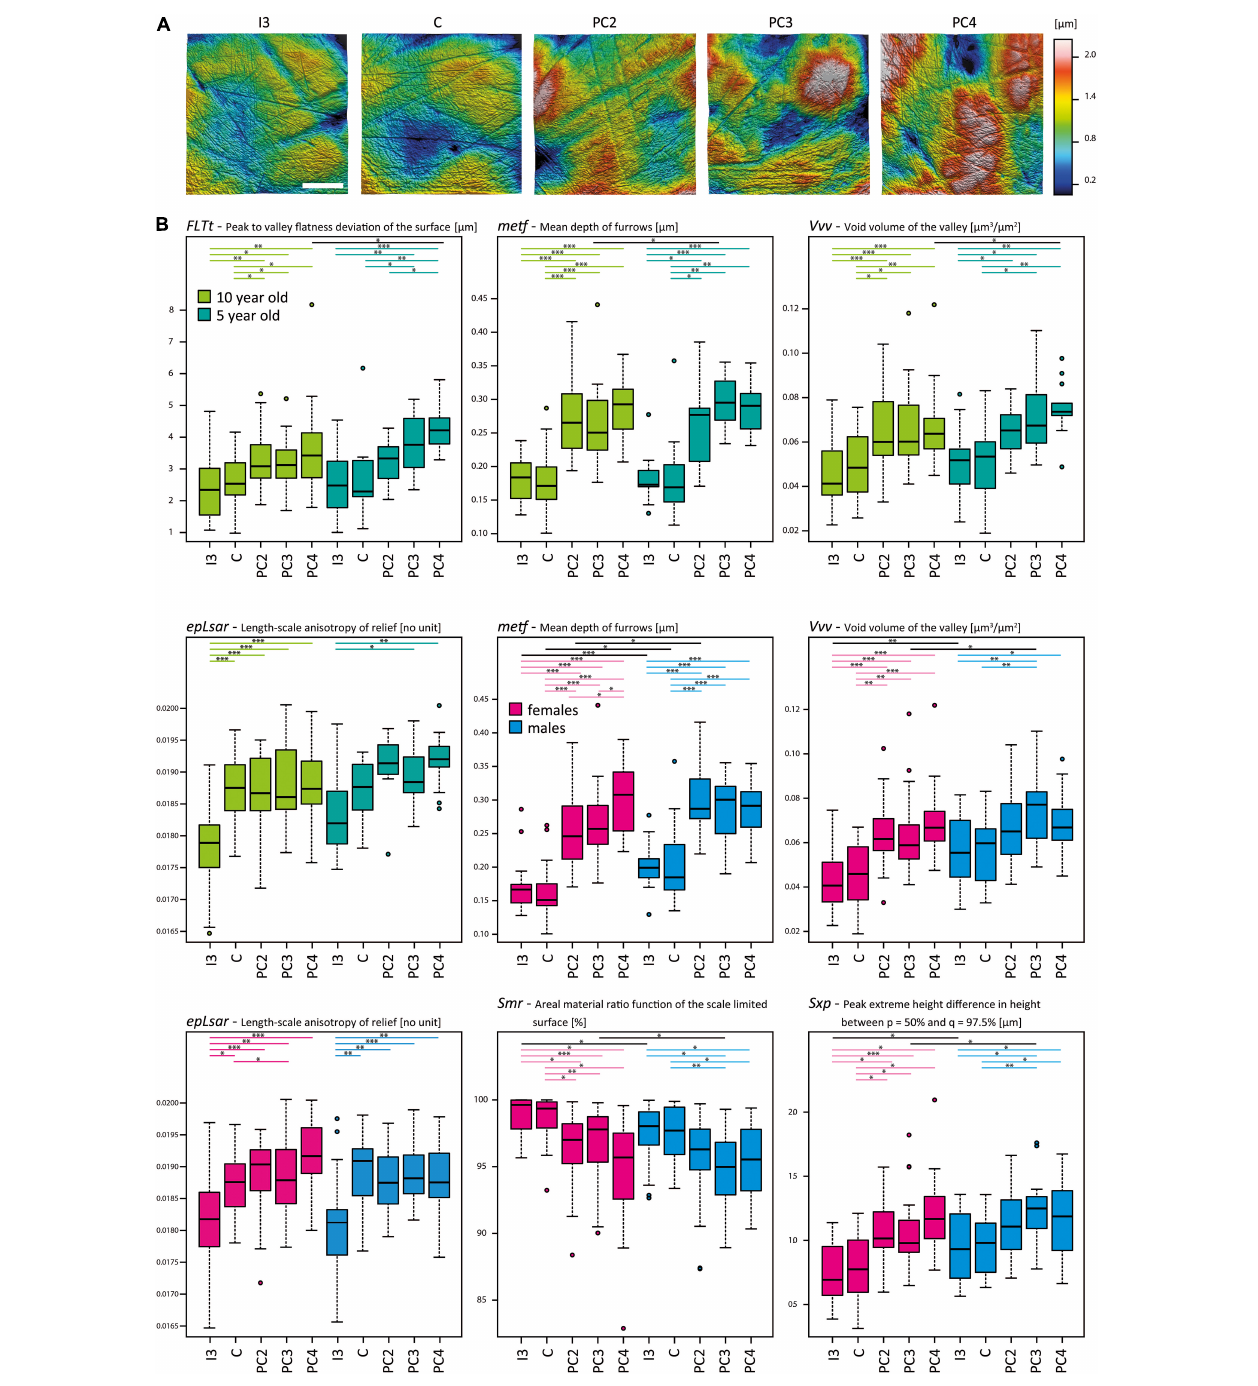
FIGURE 3 | Dental microwear texture in the upper dentition of Phoca vitulina . (A) Three-dimensional (3D) microwear textures in Phoca vitulina (ZIK-28348) for all examined tooth positions. The textures are sorted from mesial to distal along the upper dentition. Scale = 40 µ m. (B) Boxplots of selected surface texture parameters measured along the upper dentition of Phoca vitulina specimens at the age of 10 years (light green) and 5 years (dark green) as well as female (pink) and male (blue) specimens. The boxplots are sorted from mesial to distal teeth. Microwear texture parameters: FLTt = Peak to valley flatness deviation of the surface [ µ m] (ISO 12781), metf = Mean depth of furrows [ µ m] (Motif), epLsar = Length-scale anisotropy of the relief [no unit] (SSFA), Vvv = Void volume of the valley at a given material ratio ( p = 80%) [ µ m 3 / µ m 2 ] (ISO 25178), Smr = Areal material ration [ µ m] (ISO 25178), Sxp = Peak extreme height [ µ m] (ISO 25178). Test statistics following the established protocol (Calandra et al., 2012) combining the Welch-Yuen-Test, the equivalent of Dunnett’s T3-test, and Cliff’s method; significance levels: ∗ = p ≤ 0.05, ∗∗ = p ≤ 0.01, ∗∗∗ = p ≤ 0.005. Abbreviations for tooth positions from mesial to distal teeth: I3, third upper incisor; C, canine; PC2, second postcanine; PC3, third postcanine; PC4, fourth postcanine.